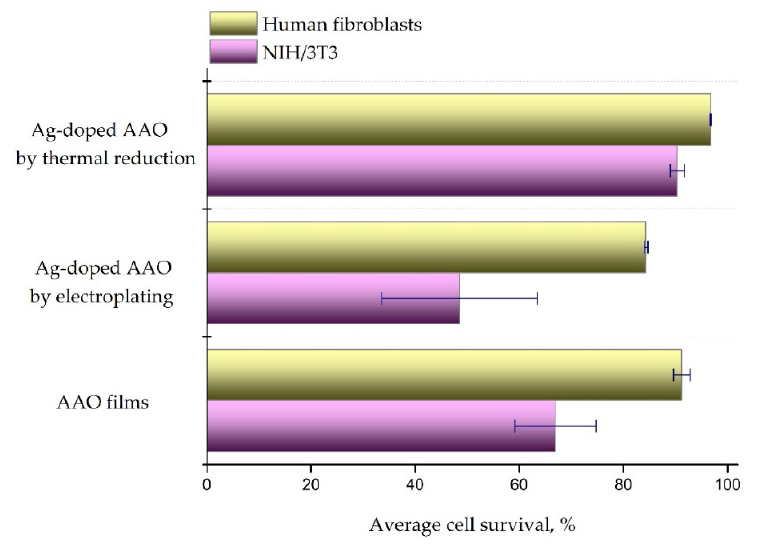
Figure 11. Average cell survival levels determined after 48 h in vitro culture of NIH/3T3 and human fibroblast cells with modified alumina substrates. All samples were tested in duplicates ( n = 4). Figure bars represent mean ± standard error of the mean, and ± SD is indicated for each group.